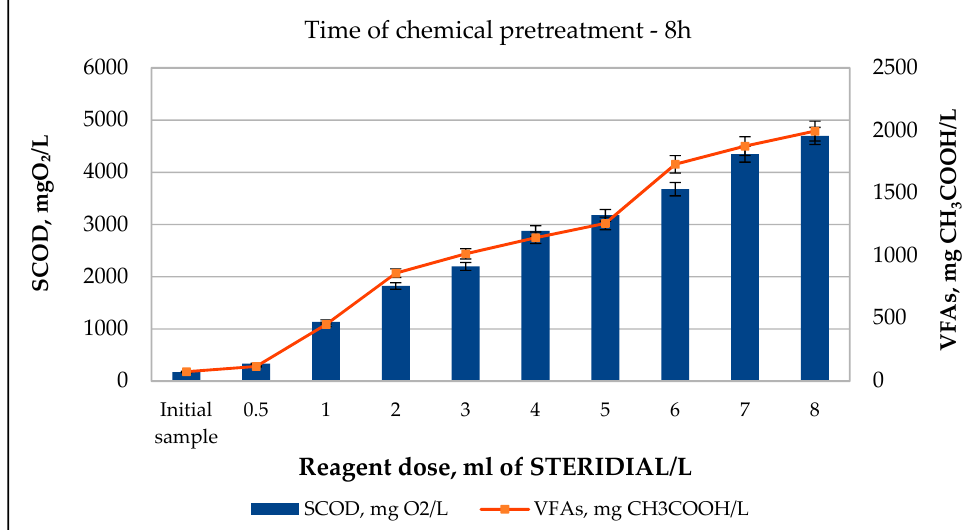
Figure 7. Changes in soluble chemical oxygen demand (SCOD) and concentration of volatile fatty acids (VFAs) determined in the supernatant liquor of chemically disintegrated excess sludge (pre- treatment time: 8 h) recorded in relation to the reagent doses used. As a result of the disintegration of sludge by adding STERIDIAL W-10 solution in doses ranging from 0.5 to 8 mL/L, the values of the liquefaction factor were 1.5 to 24.7 for the pretreatment time of 1 h, 1.9 to 27.6 for the pretreatment time of 4 h, and 2.0 to 28.0 for the pretreatment time of 8 h. It was observed that for the reagent doses tested, similar values of the sludge liquefaction factor were obtained for greater treatment times (Figure 8).